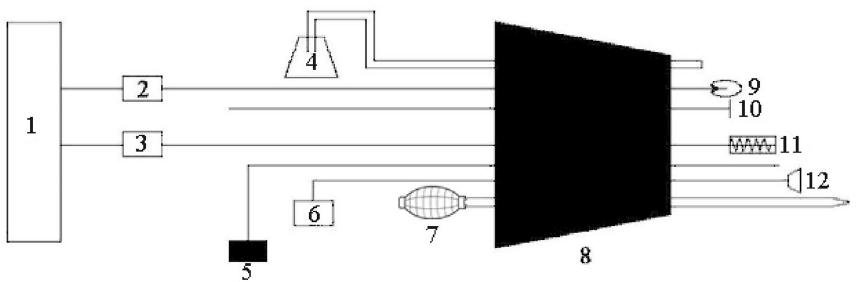
Figure 2. Schematic diagram of the rubber stopper used to simulate the entrance plug of the burrow. (1) power supply; (2) light bulb switch; (3) electric wire switch; (4) oxygen cylinder; (5) in situ three-parameter soil gas analyzer; (6) voice recorder; (7) negative pressure drainage device; (8) rubber plug; (9) LED bulb; (10) the iron rod; (11) heating cord; (12) AVOXIVY speaker with 5 cm